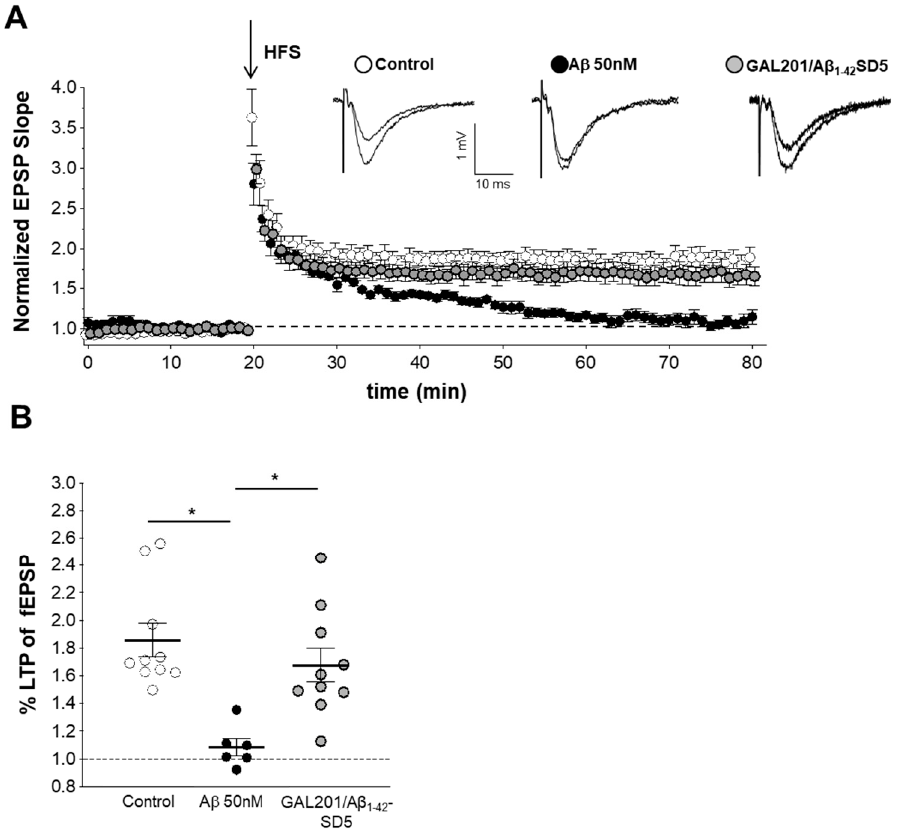
Figure 6. GAL-201 prevented synaptotoxic effects of A β 1-42 on LTP after serial dilution. ( A ) Normalized fEPSP time course following a HFS under control conditions, with 1.5 h A β 1-42 exposure alone and the concomitant application of GAL-201 and A β 1-42 via a GAL-201/A β 1-42 -SD5 solution. The insets show representative fEPSP traces of a control and A β 1-42 measurement. ( B ) Scatter dot plot summarizing the last 50 to 60 min after HFS. The fEPSP amplitude was significantly reduced by A β 1-42 (50 nM). After the “serial dilution” of GAL-201 by factor 1:10,000 (see Figure 3), the GAL-201/A β 1-42 -SD5 solution from vial #5 reversed A β 1-42 synaptotoxicity. This is explained by the formation of self-propagation A β species since the trace concentration of only 0.1 nM GAL-201 itself has been proven not to be directly pharmacologically active [34]. (* p < 0.05).